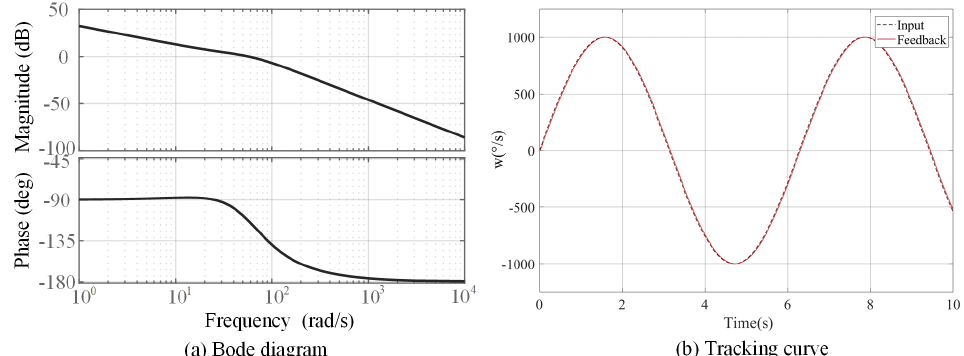
Figure 15. Open-loop Bode diagram and sine tracking curve of system after speed loop correction.